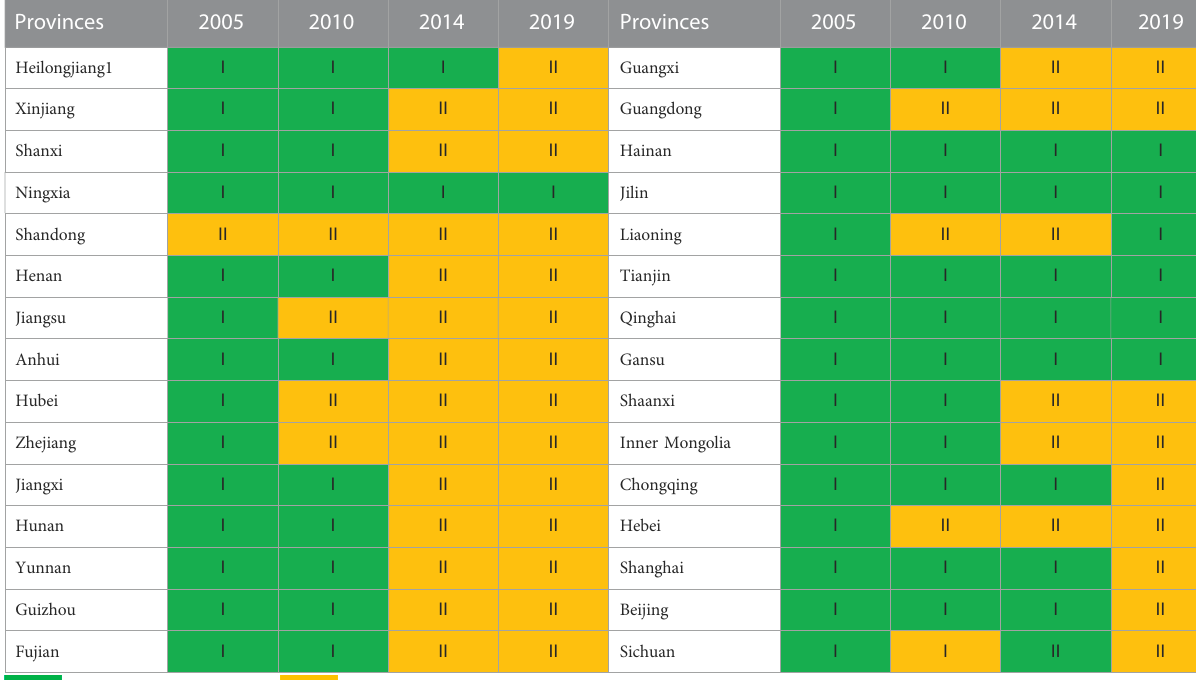
TABLE 3 Evolution of types of coupling coordination.